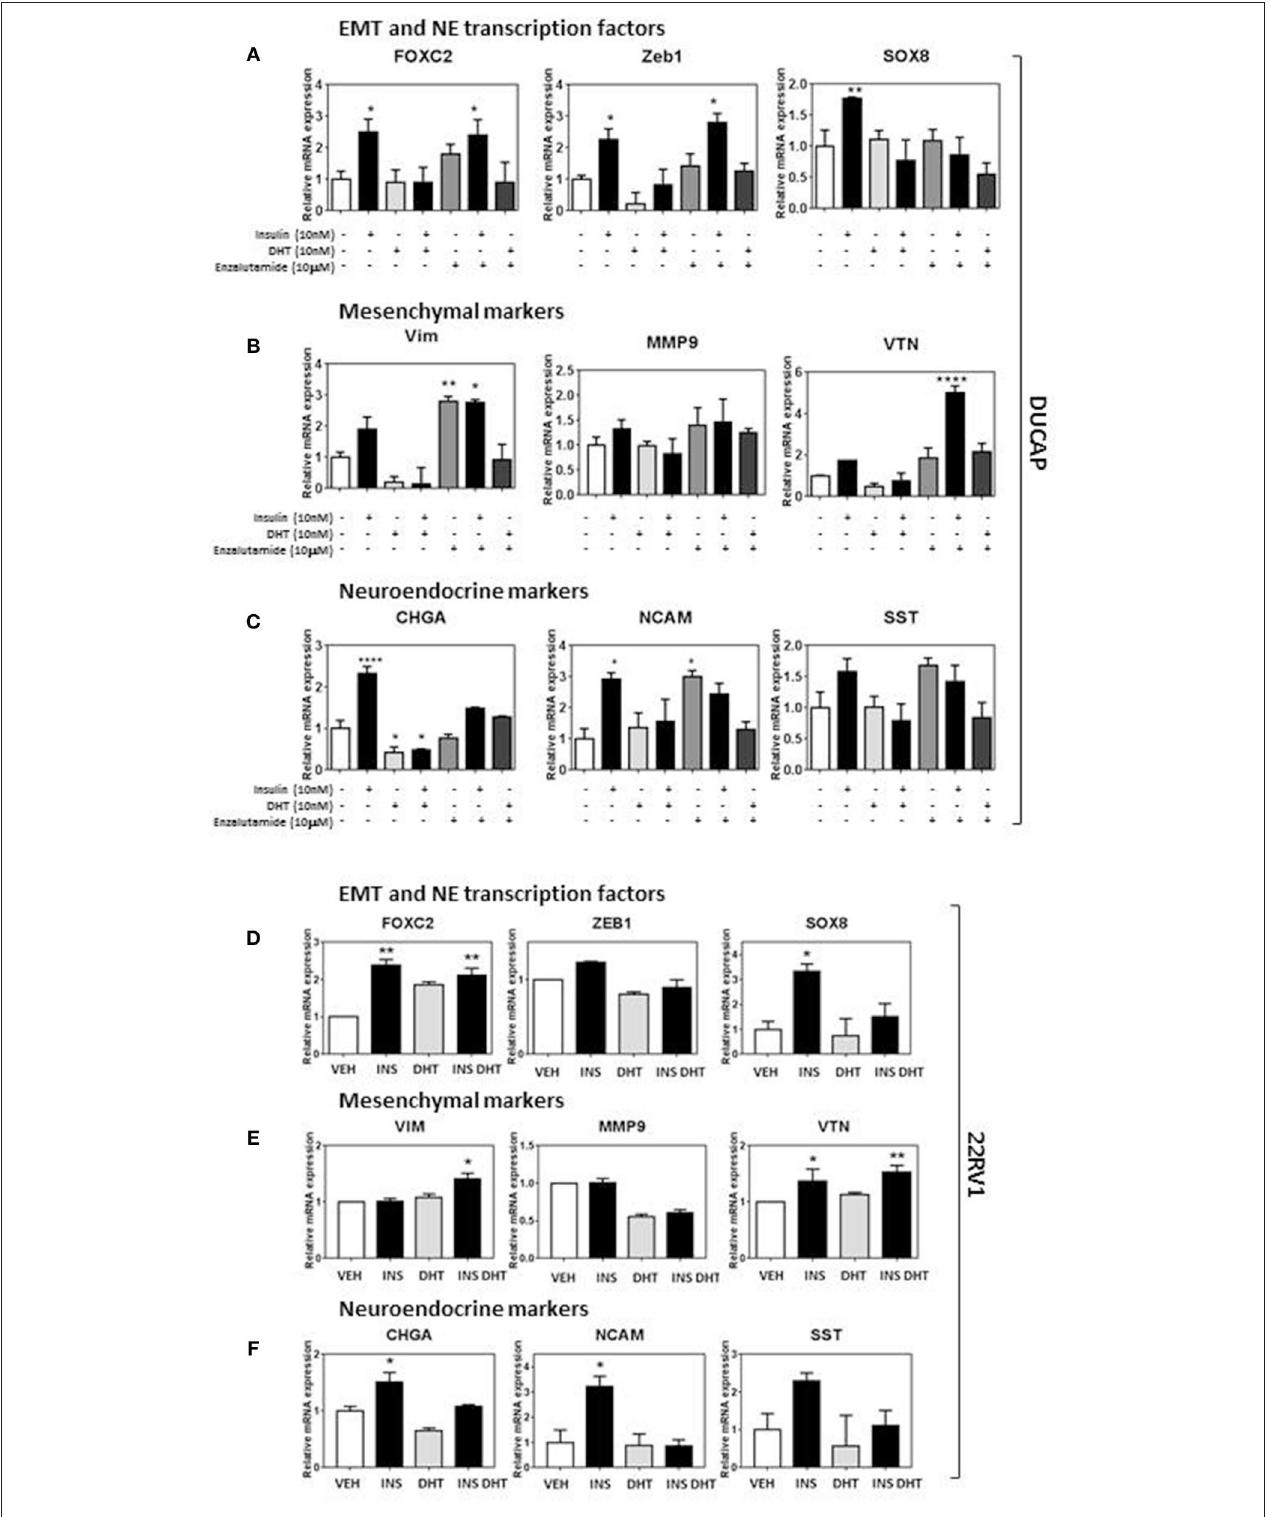
FIGURE 5 | Insulin increases EMT and NE transcriptional profile in DUCaP and 22RV1 cells. To validate the LNCaP observations, 22RV1 and DuCaP cells were cultured under androgen deprived conditions and treated with insulin (10nM), DHT (10nM), and enzalutamide (10 µ M) (48h). qRT-PCR shows that levels of both (A) EMT and NE transcription factors FOXC2, ZEB1, and SOX8 significantly increase in DuCaP cells with insulin treatment, along with non-significant increases in (B)